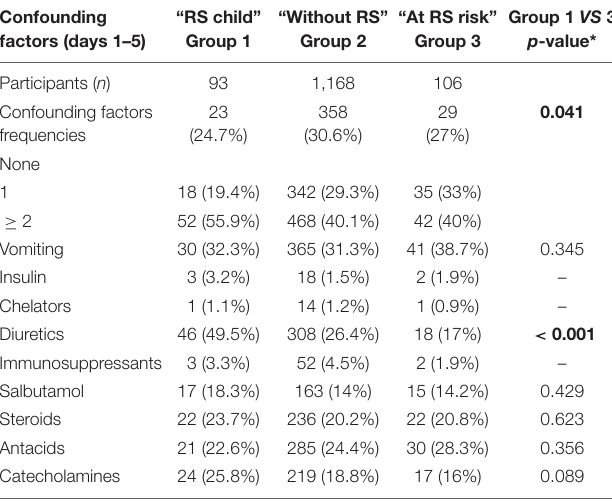
TABLE 4 | Confounding factors in the three